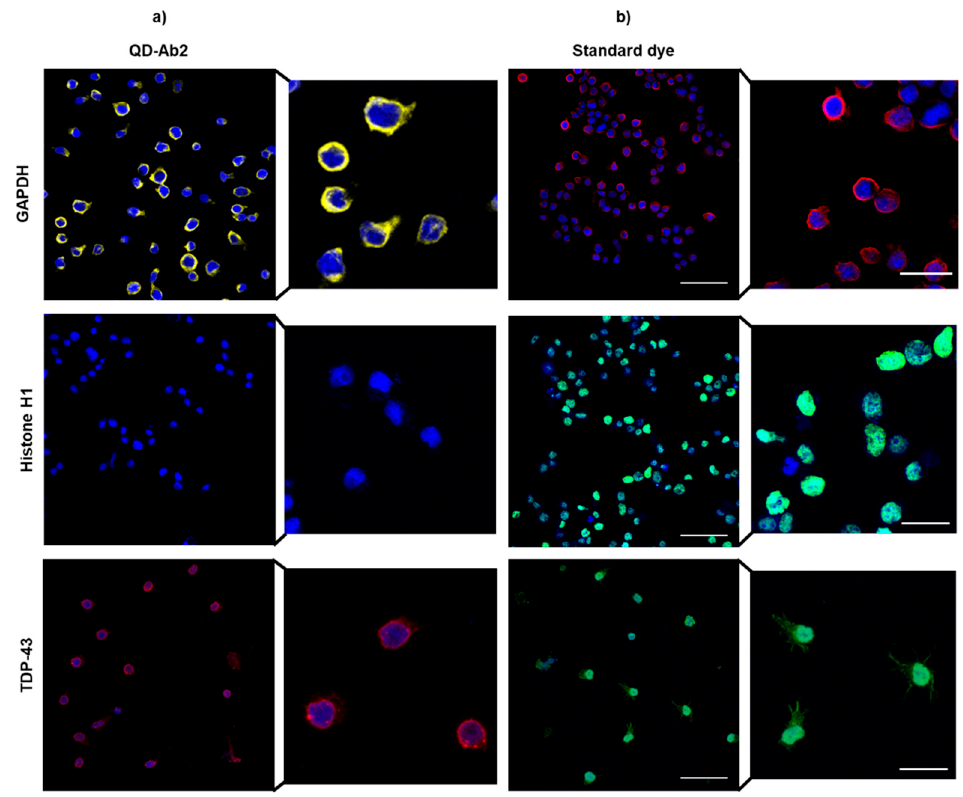
Figure 8. ALS lymphoblasts were labelled with GAPDH, Histone H1 and TDP-43 with ( a ) QD-Ab2 and ( b ) standard dye for multiple comparison. No nuclear staining was observed with QD-Ab2 even using PK 30 µg/mL. GAPDH and cytoplasmic TDP-43 were stained using Triton 0.25% as permeabilization reagent. Nuclei were stained with HCS Nuclear Mask Deep Red. Scale bar: 20 µm.